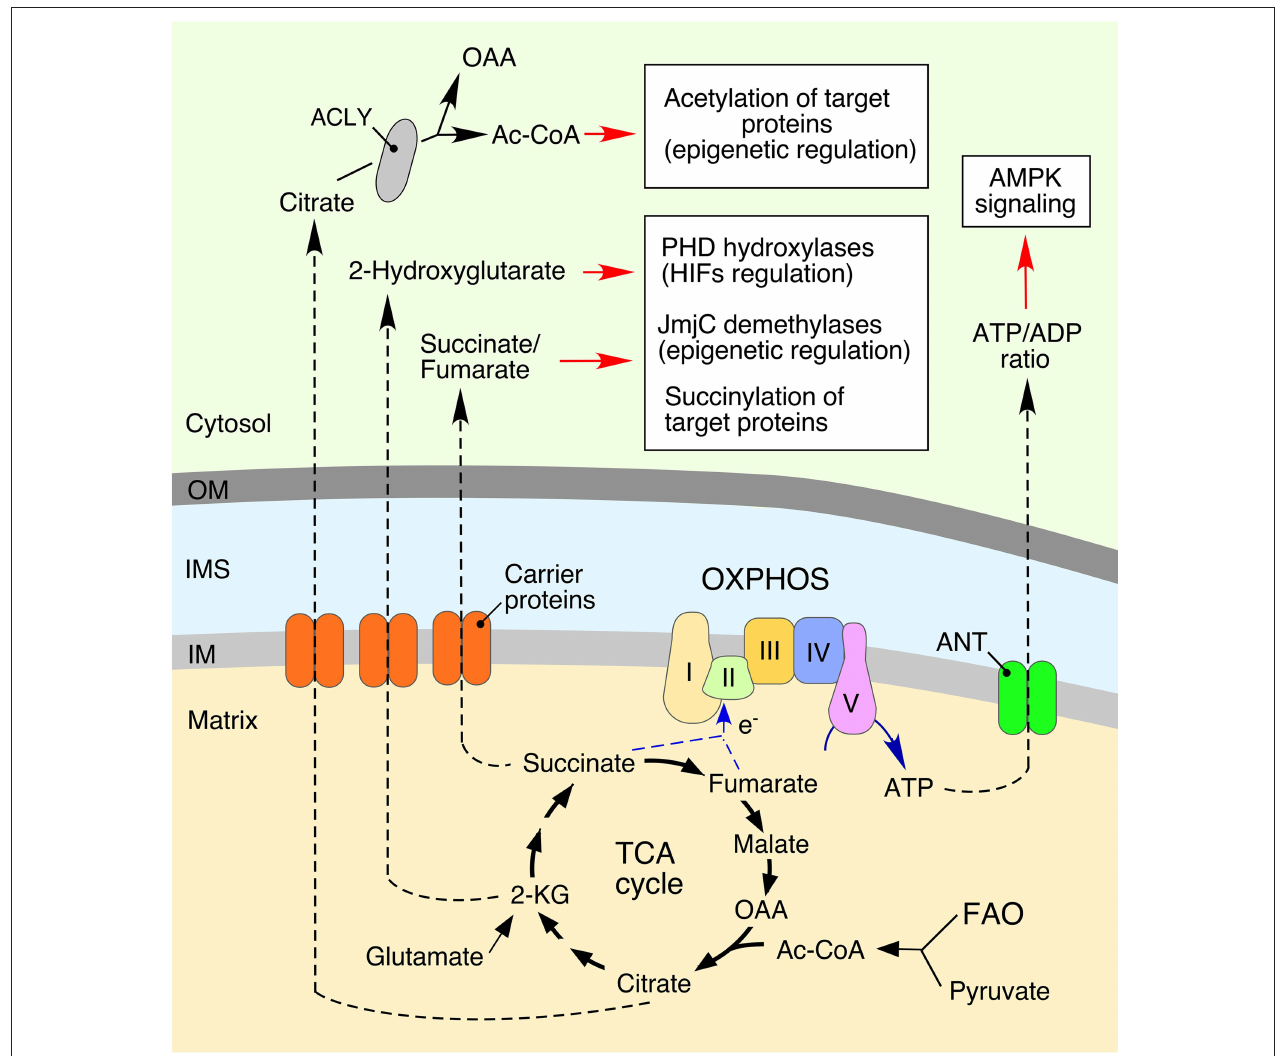
FIGURE 1 | Mitochondria-derived metabolites regulate various cellular processes. Bioenergetic function of mitochondria is associated with generation of ATP (adenosine triphosphate) via the oxidative phosphorylation (OXPHOS) system. This process involves conversion of various substrates imported from the cytosol via the tricarboxylic acid (TCA) cycle or fatty acid oxidation (FAO). Metabolic intermediates can be exported into the cytosol to impact various signaling cascades. Mitochondria-derived citrate is converted to oxaloacetate (OAA) and acetyl coenzyme A (Ac-CoA) by ATP citrate lyase (ACLY). Subsequently, a fraction of the cytosolic Ac-CoA can be used in protein acetylation, thereby impacting multiple cellular processes (Choudhary et al., 2009; Spange et al., 2009; Wellen et al., 2009; Eisenberg et al., 2014). Another TCA cycle biosynthetic intermediate, 2-ketoglutarate ( α -KG), can be converted to 2-Hydroxyglutarate. This metabolite inhibits: (1) Jumonji C domain-containing demethylases (JmjC), affecting epigenetic reprogramming (Pearce et al., 2013; Zong et al., 2016); and (2) hypoxia-inducible prolyl hydroxylases (PHDs), thus stabilizing the hypoxia-inducible factors (HIFs) and inducing a hypoxic response (Xu et al., 2011; Pearce et al., 2013; Zong et al., 2016). The TCA metabolite, fumarate, can also act as a signal-modulating factor via its ability to bind lysine residues of various proteins, resulting in a post-translational modification called succinylation. The adenine nucleotide translocator (ANT) mediates an exchange of ATP and cytosol-derived ADP (adenosine diphosphate) across the inner mitochondrial membrane (IM). Mitochondrial dysfunction derived ATP depletion perturbs ATP/ADP ratios by subsequent activation of adenosine monophosphate-activated protein kinase (AMPK), a master regulator of cellular energy homeostasis (Hall et al., 2013; Pearce et al.,